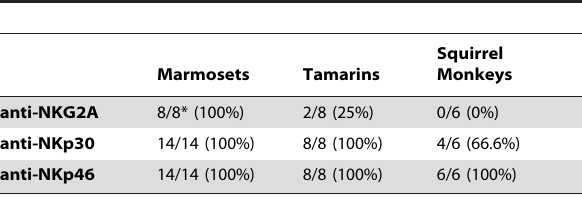
Table 1. Variable cross-reactivity of NK cell-specific antibodies among